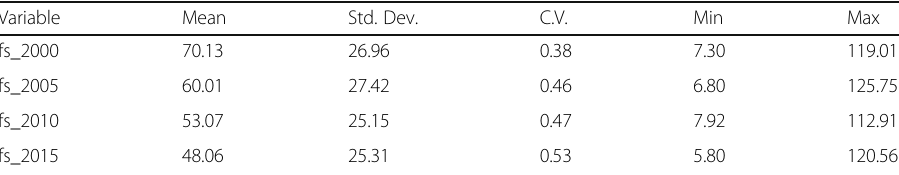
Table 5 Descriptive statistics of social lag factorial scores. Mexico 2000 – 2015 Variable Mean Std.